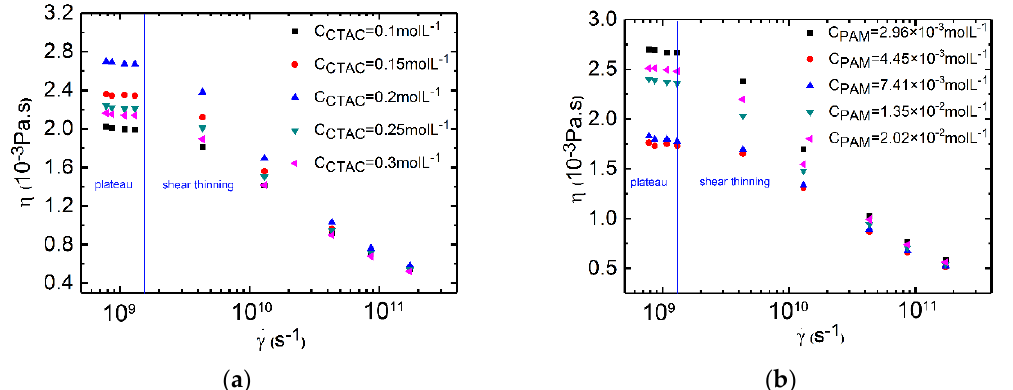
Figure 2. ( a ) Simulation of shear viscosity versus shear rates for the PAM based solutions. C PAM = 2.96 × 10 − 3 mol·L − 1 , Counter ion salt: NaSal, R = 0.8, T = 300 K. Black square: C CTAC = 0.1 mol·L − 1 . Red circle: C CTAC = 0.15 mol·L − 1 . Blue triangle: C CTAC = 0.2 mol·L − 1 . Dark cyan triangle: C CTAC = 0.25 mol·L − 1 . Magenta triangle: C CTAC = 0.3 mol·L − 1 . ( b ) Simulation of shear viscosity versus shear rates for CTAC based solutions. C CTAC = 0.2 mol·L − 1 , counter ion salt: NaSal, R = 0.8, T = 300 K. Black square: C PAM = 2.96 × 10 − 3 mol·L − 1 . Red circle: C PAM = 4.45 × 10 − 3 mol·L − 1 . Blue triangle: C PAM = 7.41 × 10 − 3 mol·L − 1 . Dark cyan triangle: C PAM = 1.35 × 10 − 2 mol·L − 1 . Magenta triangle: C PAM = 2.02 × 10 − 2 mol·L − 1 .